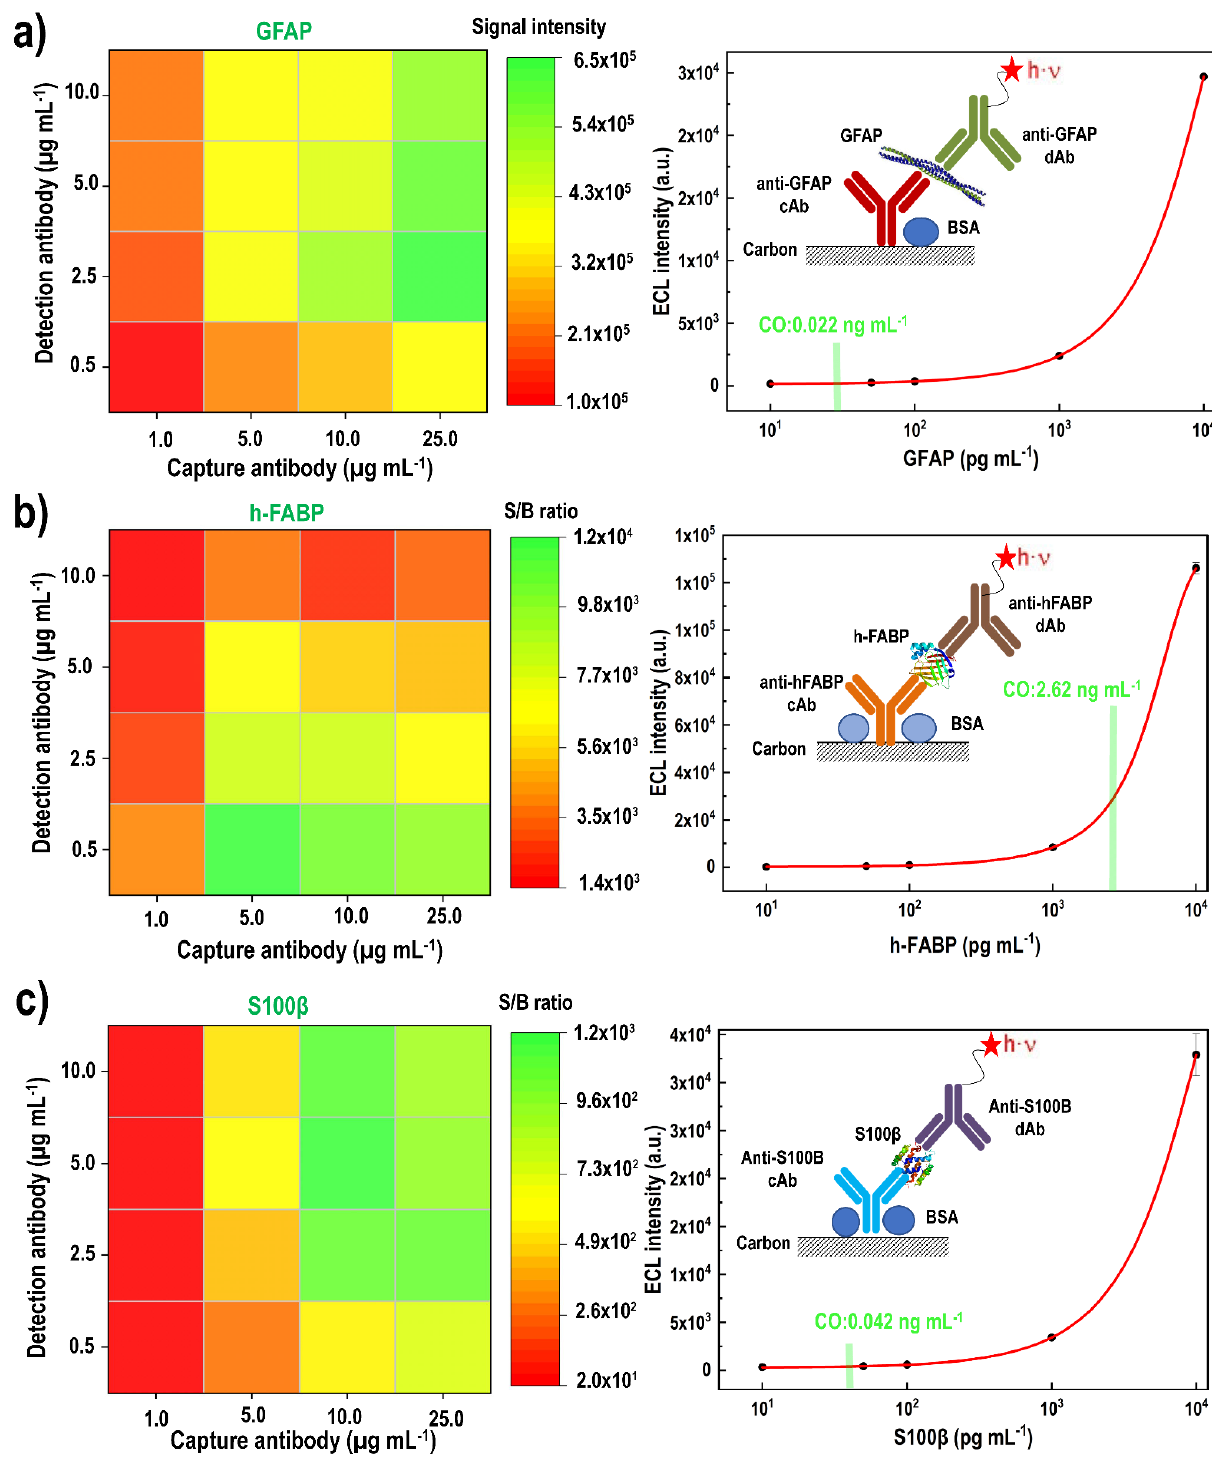
Figure 1. ECL sandwich immunoassays for mTBI-relevant biomarkers on the MSD platform in a 96-well plate format: ( a ) GFAP, ( b ) h-FABP, and ( c ) S100 β . Left figures—Optimization of antibody concentrations in the sandwich assay: checkerboard optimization assay for the antibody pairs with the x -axis representing the capture antibody concentrations and the y -axis the detection antibody concentrations. The results are visualized as a heat map plot with reported signal intensities or S/B ratios (100 ng mL − 1 /blank). Right figures—ECL calibration curves established using the conditions listed in Table 2. The error bars represent the standard deviation from three replicates; bars are smaller than the data symbol employed. CO—cutoff value for the biomarker.